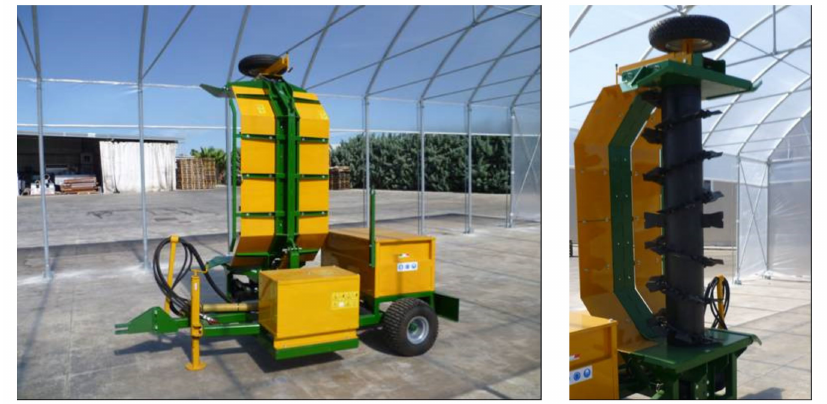
Figure 2. Turner machine ( left ); detail of the rotating shaft ( right